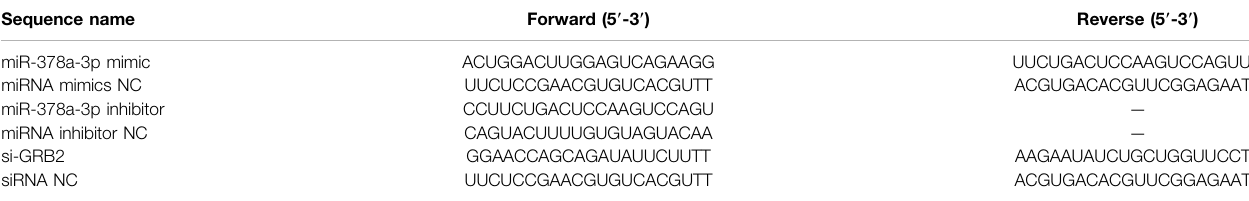
TABLE 3 | Sequences of the speci fi c miRNA and